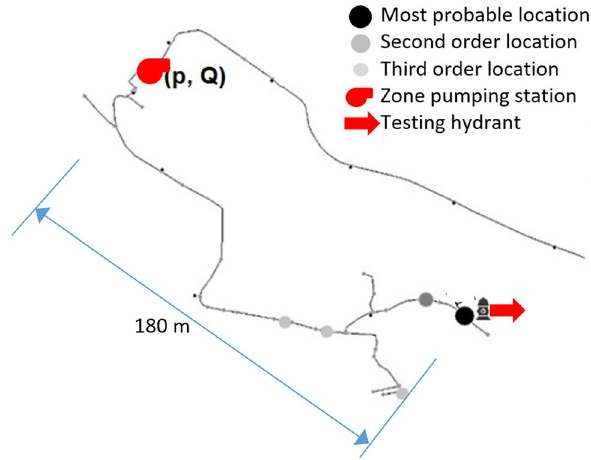
Fig. 10 Indication of the most probable leakage location in the ana- lysed